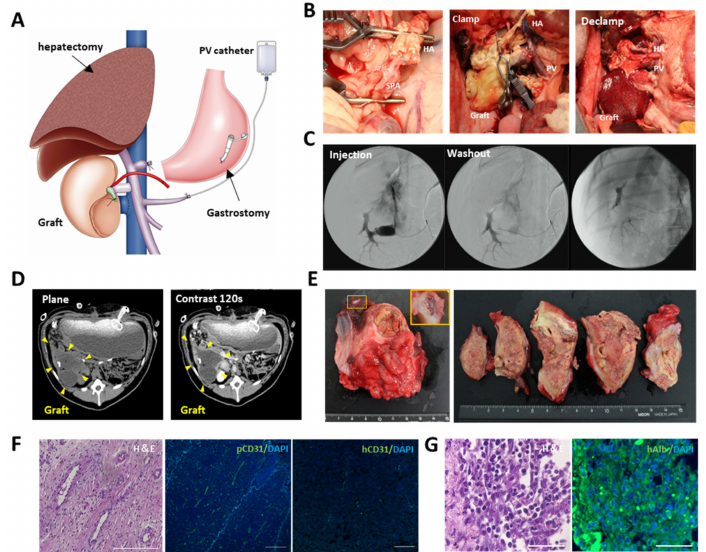
Figure 4. Transplantation of the engineered liver grafts by vascular anastomosis. ( A ) Schema for transplantation of the recellularized scaffold. Partial (60%) hepatectomy, intraportal infusion catheter, and gastrostomy were conducted during surgery. ( B ) Macroscopic images of the transplantation procedure. Left: anastomosis between hepatic artery of the scaffold and the splenic artery of the recipient. Middle: the scaffold before blood perfusion. Right: the scaffold after blood